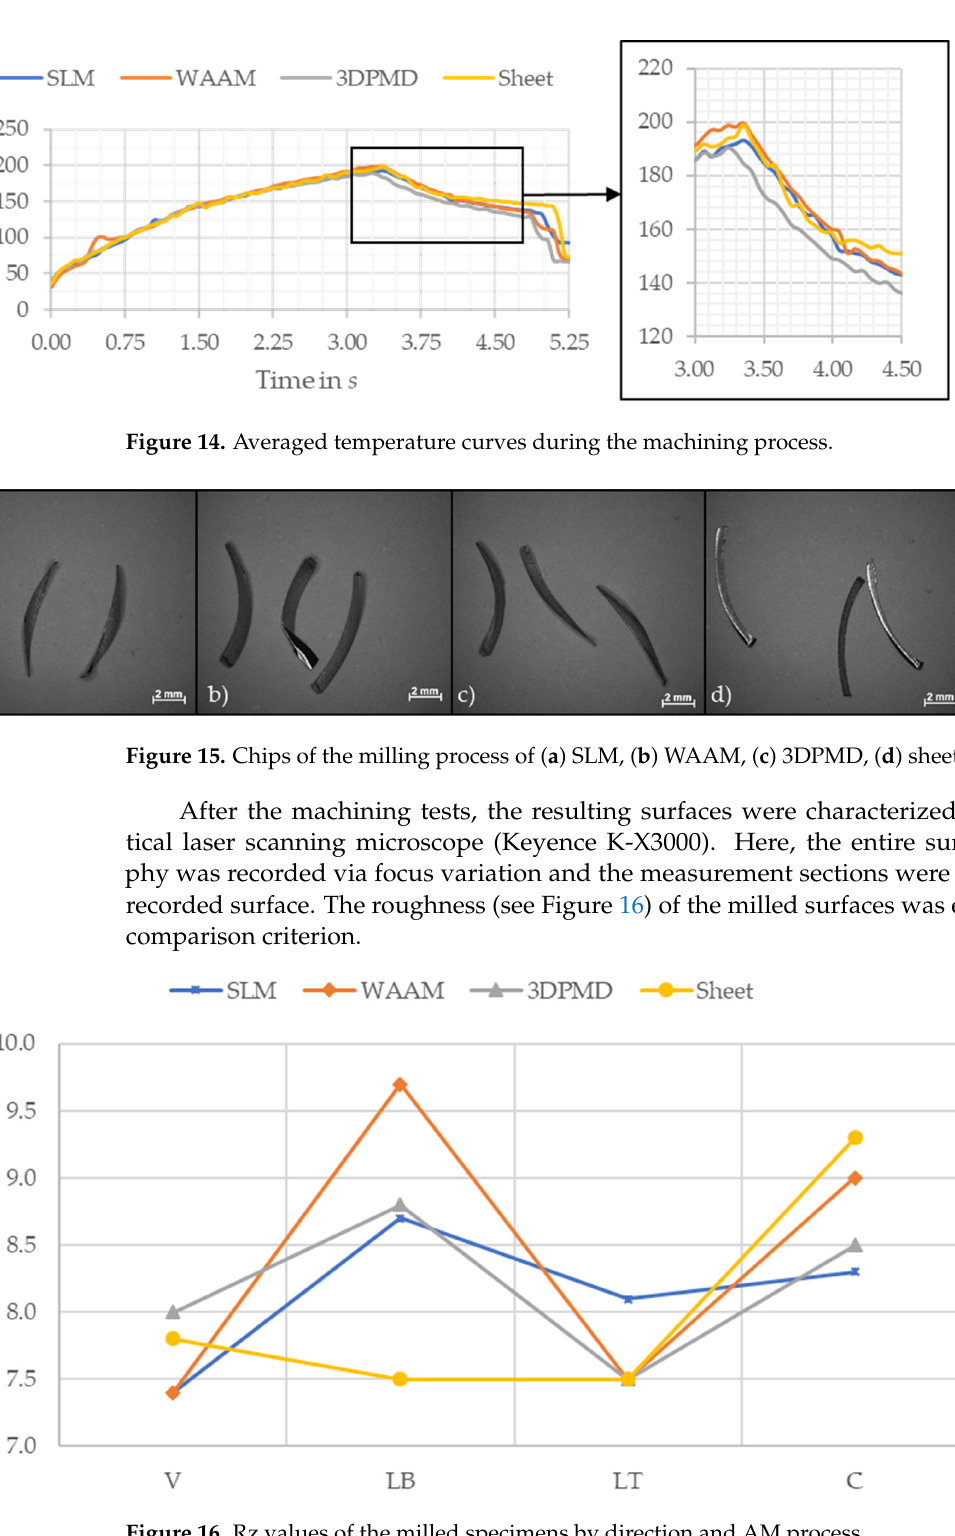
Figure 16. Rz values of the milled specimens by direction and AM process.